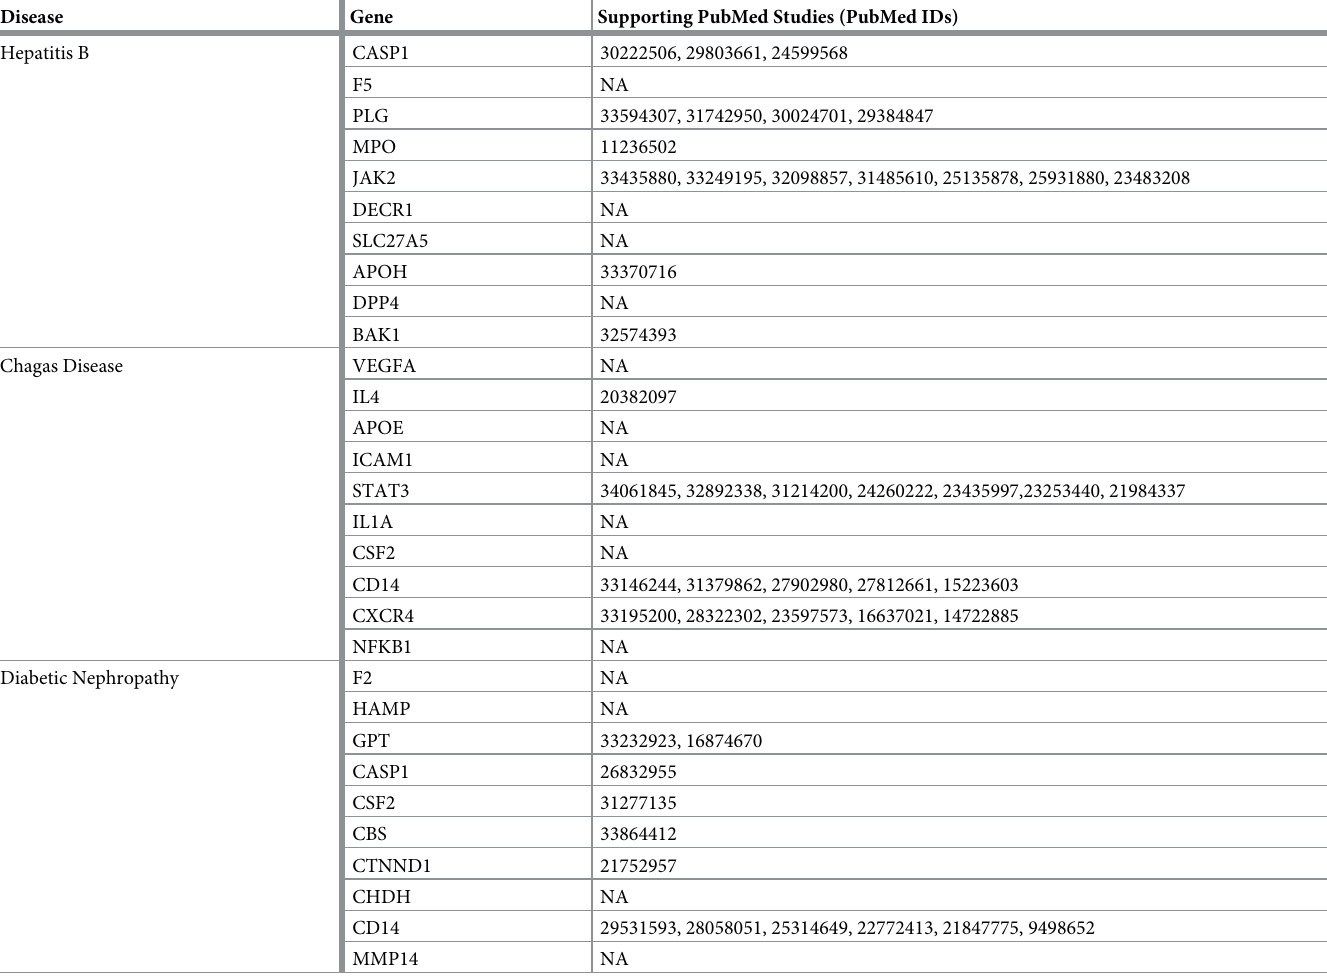
Table 4. Literature review for Top 10 predicted genes for 3 example diseases. Genes are listed in descending ranked order. For example, for Hepatitis B, CASP1 and BAK1 are ranked 1 (best) and 10, respectively. Disease Gene Supporting PubMed Studies (PubMed IDs) Hepatitis